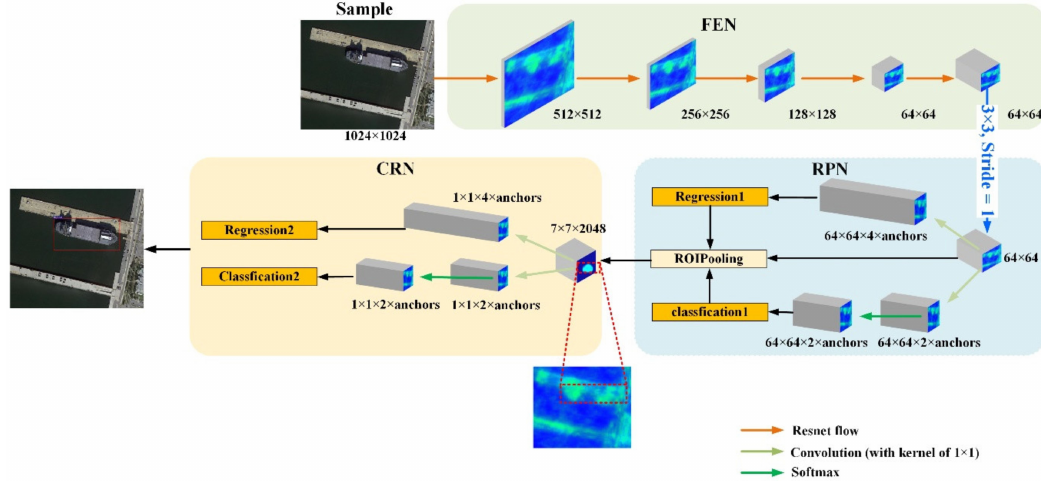
Figure 4. The structure of the object detection